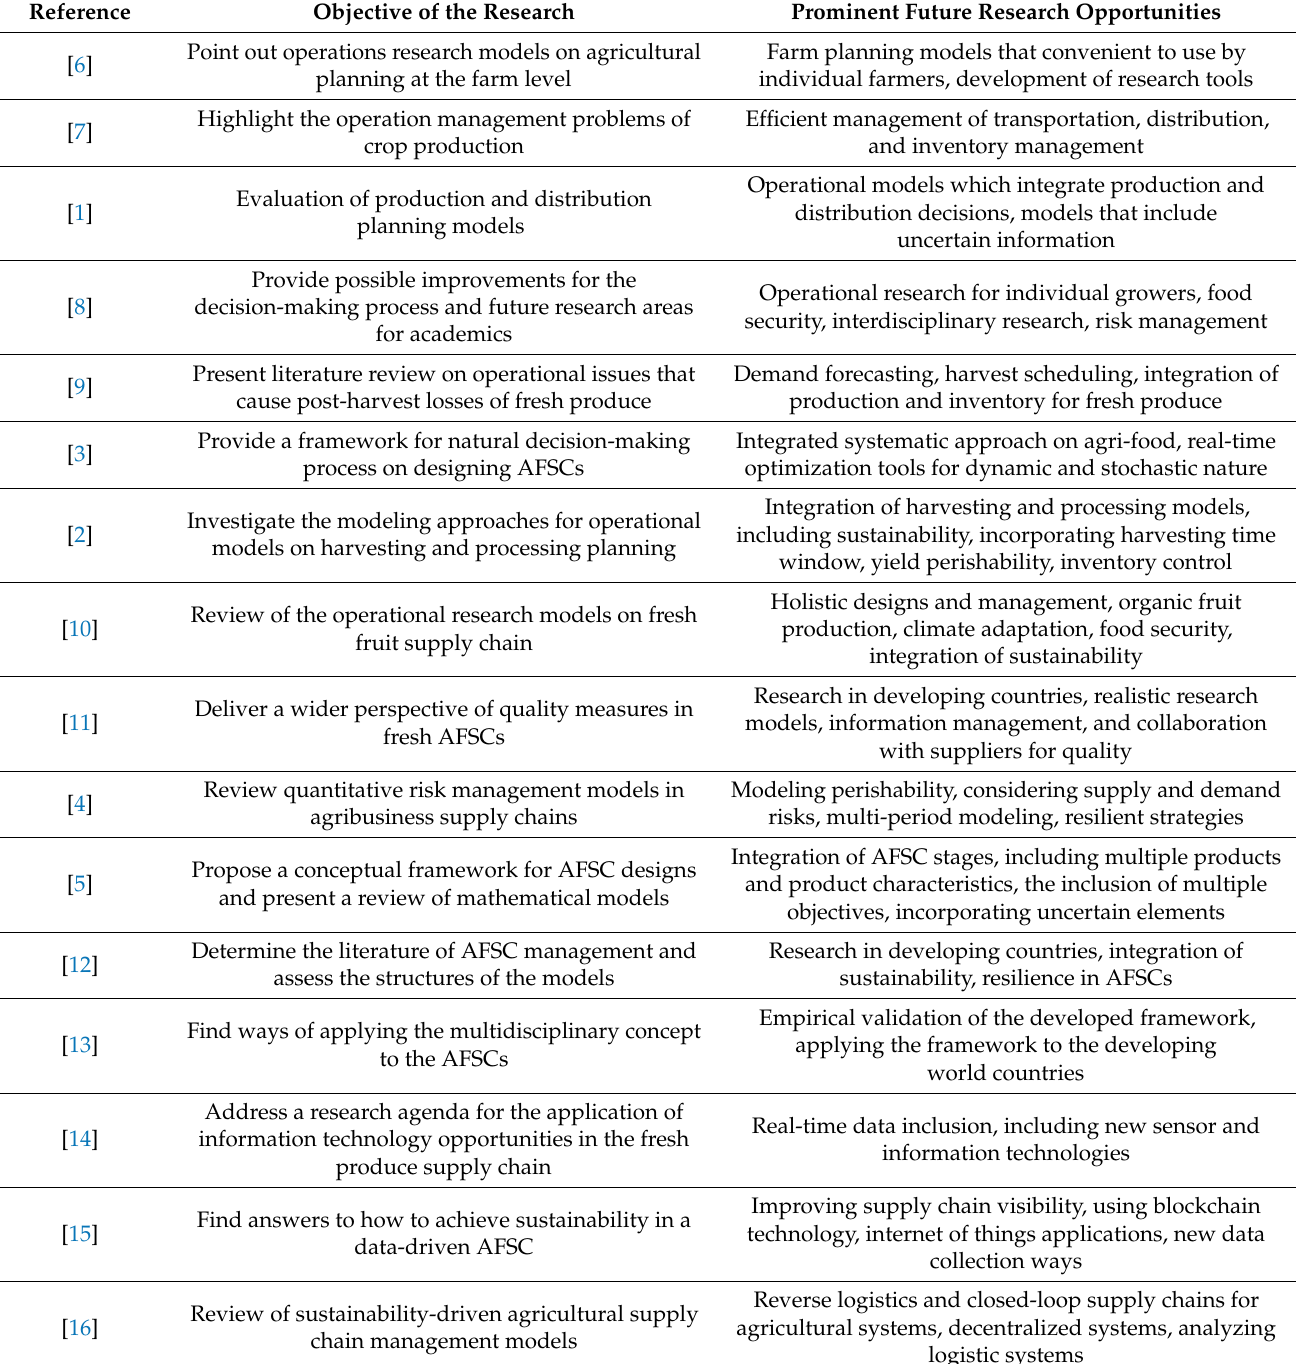
Table 1. Previous review